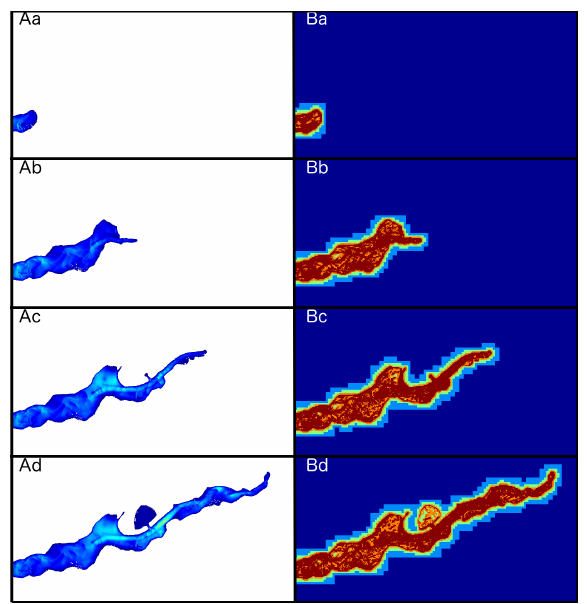
Figure 9. Picture of the water depth (A) and the refinement level (B) at t = 21s (a) , t = 35s (b) , t = 49s (c) m and t = 63s (d) . The min- imum value for the water height (A) is 1cm, corresponding to the dark blue colour, and the maximum is 40cm, corresponding to the light blue colour. For the refinement level (B) , the minimum value is a cell of 68cm × 68cm, corresponding to dark blue, and the max- imum value is a cell of 4.2cm × 4.2cm, corresponding to